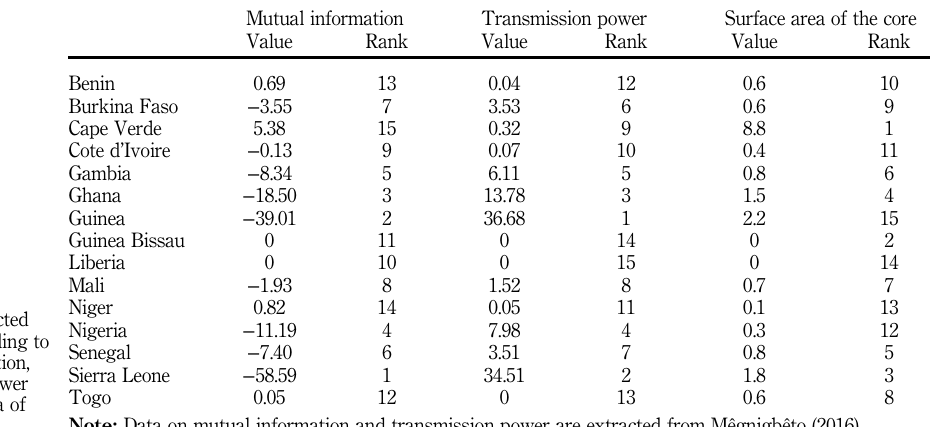
Table VI. Ranking of selected countries according to mutual information, transmission power and surface area of the